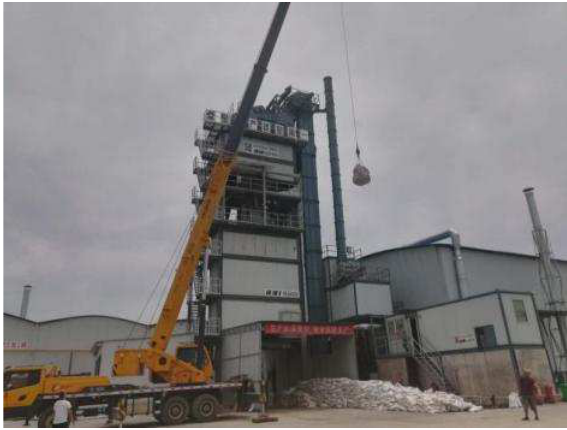
Figure 8. Hoisting the snow-melting salt into the mixing plant. Table 15. The amount of materials required for one mixing.